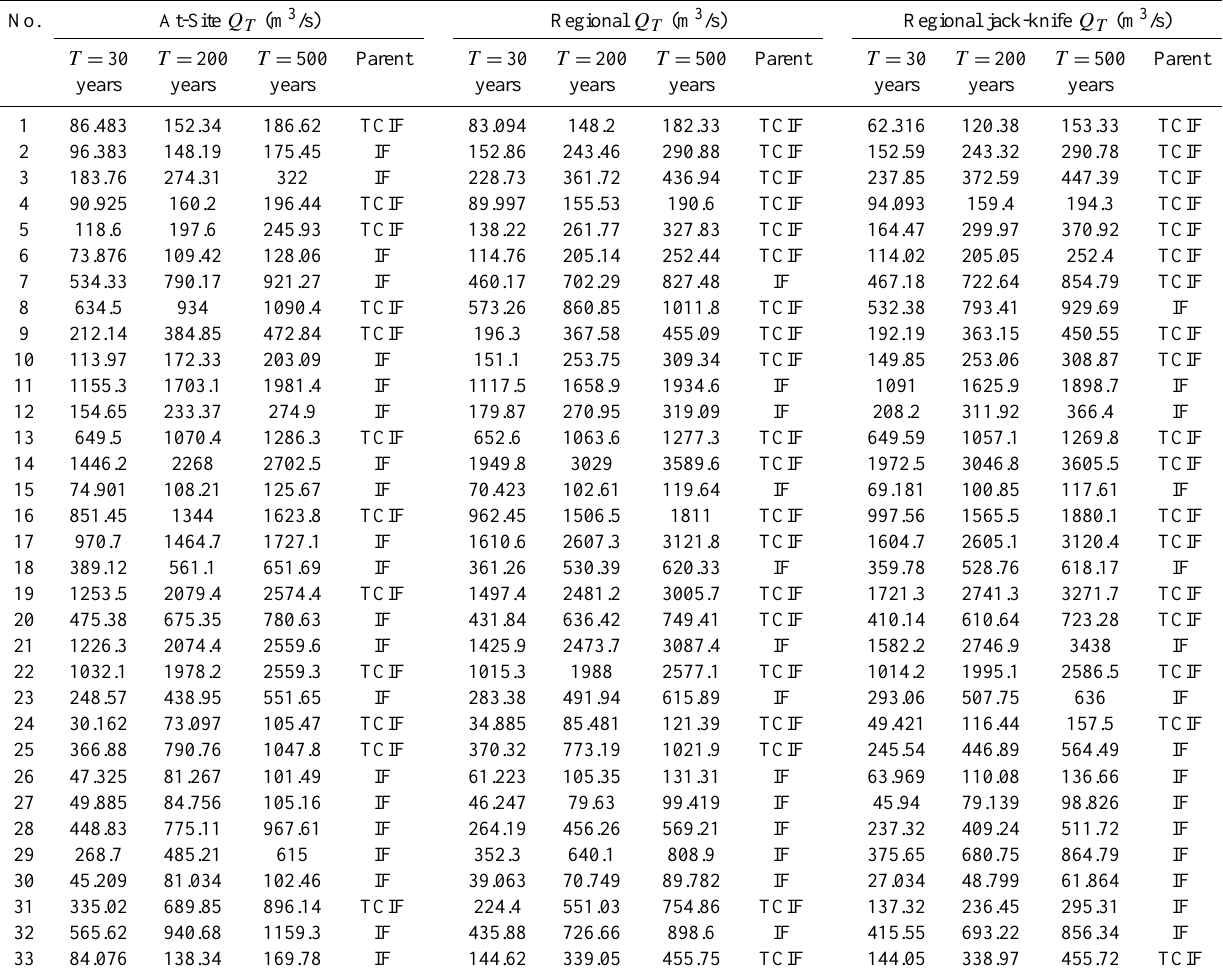
Table 6. Quantiles of the TCIF and IF models with return periods of 30, 200 and 500 years. No. At-Site Q T (m 3 /s) Regional Q T (m 3 /s) Regional jack-knife Q T (m 3